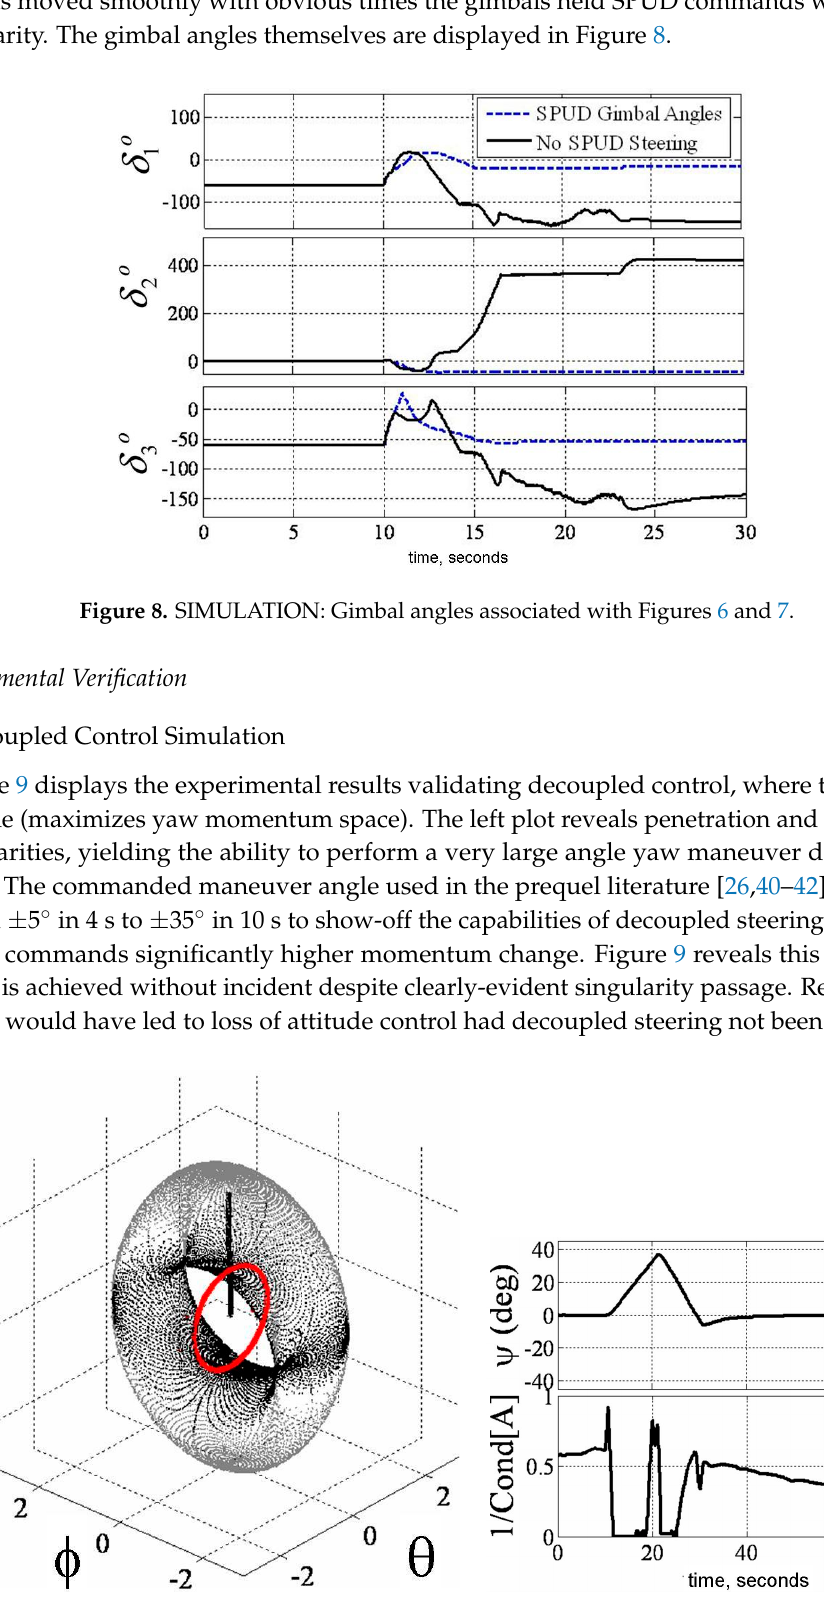
Figure 9. EXPERIMENTATION: Validating efficacy of decoupled control.